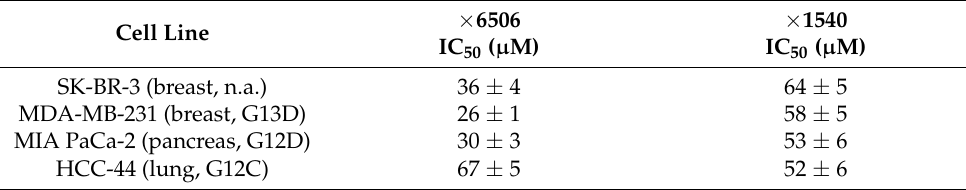
Table 3. Effects of the compounds on 3D spheroid